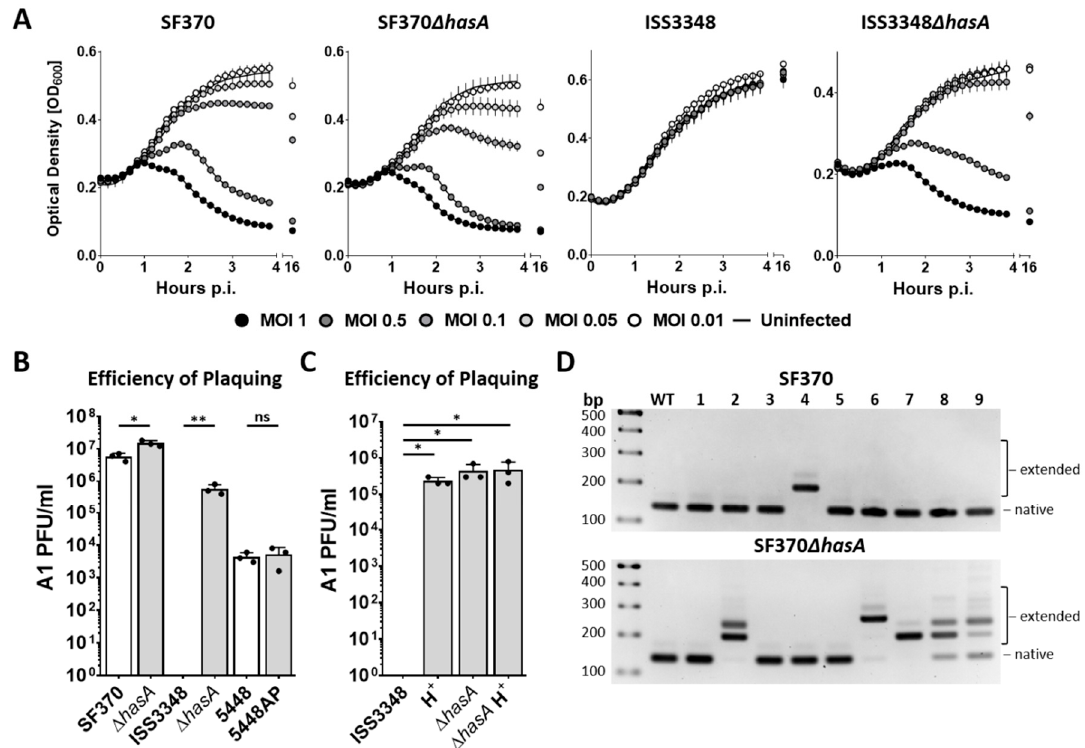
Figure 5. Impaired capsule-based phage resistance results in more detectable CRISPR-Cas-mediated spacer acquisition. ( A ) Lysis profiles of Phage A1 on S. pyogenes SF370, ISS3348, and their isogenic ∆ hasA strains. Each curve shows mean values ± SD of one out of three experiments in triplicates; ( B ) Phage A1 efficiency of plaquing (EOP) on various M1 serotype S. pyogenes , and their isogenic ∆ hasA or CovS mutant strain; ( C ) Phage A1 EOP on S. pyogenes ISS3348 and ISS3348 ∆ hasA grown in the absence or presence of hyaluronidase (H + ); ( B,C ) Results are presented as mean values ± SD from three independent experiments. p < 0.05 determined by paired t tests was considered statistically significant. * p < 0.05, ** p < 0.01, NS = not significant; ( D ) Representative agarose gels showing amplified CRISPR arrays of WT S. pyogenes SF370 (up), SF370 ∆ hasA (down), and 9 surviving colonies (1–9) for both strains after Phage A1 infection.